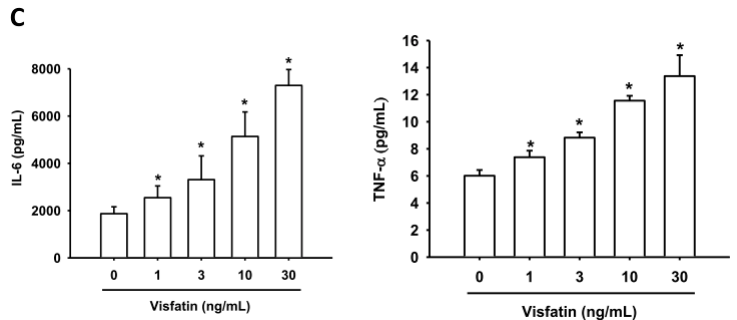
Figure 1. Visfatin induces IL-6 and TNF- α expression in human synovial fibroblasts. Osteoarthritis synovial fibroblasts (OASFs) were incubated with various concentrations of visfatin for 24 h. ( A – C ) IL-6 and TNF- α expression was examined by qPCR, Western blot and ELISA assay. Results are expressed as the mean ± SEM. * p < 0.05 as compared with baseline.